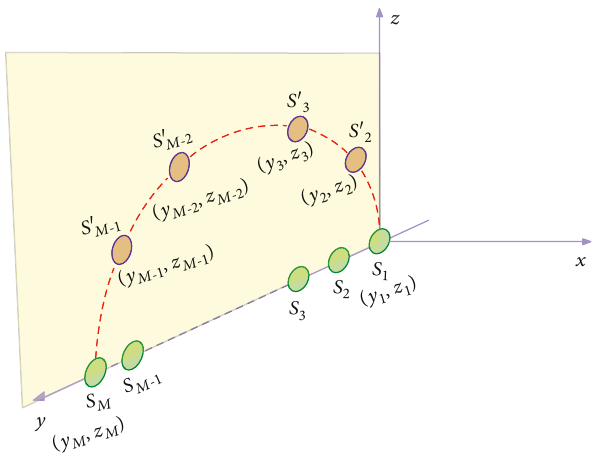
Figure 1: Uniform linear array (ULA) along the y -axis bent into a semicircular arc in the yz -